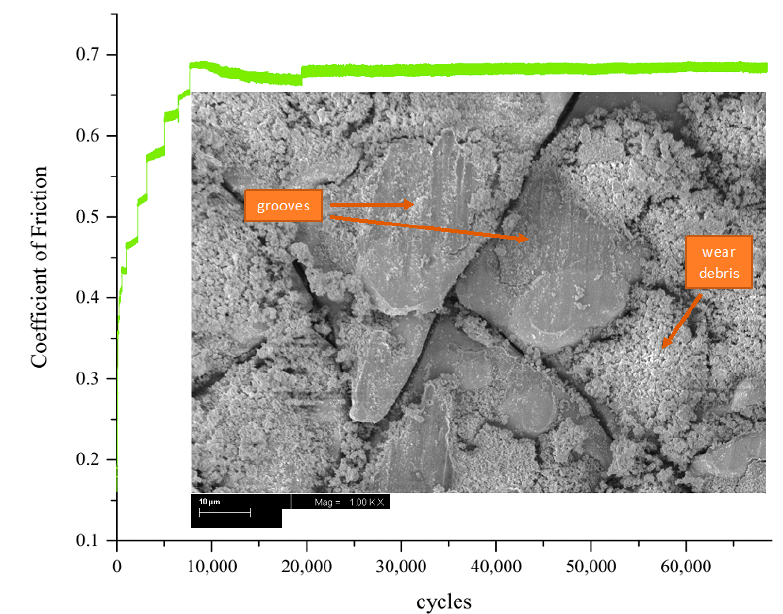
Figure 15. Variation of the coefficient of friction of Ni-P plated PHNBR sample at 5 N for 69,000 cycles and SEM micrograph of the sample after the test.